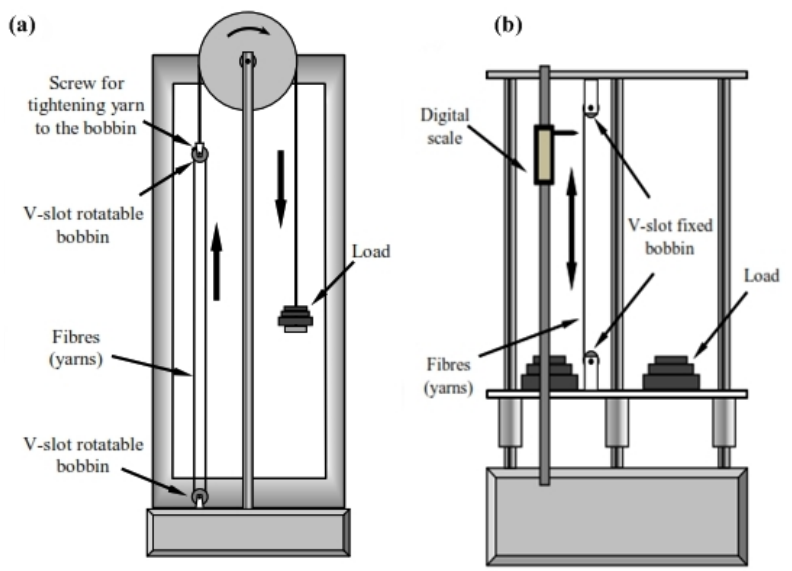
Figure 12. Vertical stretching rigs for VPPMC fibre-prestressing [6] Rig ( a ), Rig ( b ).